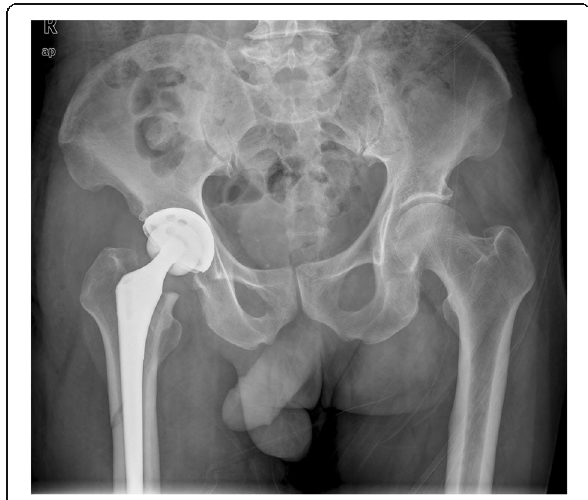
Fig. 1 Anteroposterior radiograph of the right hip in postoperative